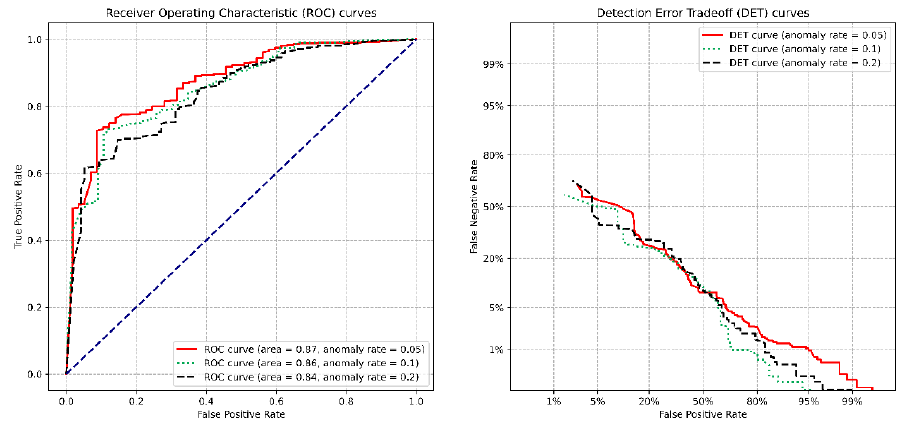
Figure 10. ROC and DET of Log BPIC2013_closed_issue.